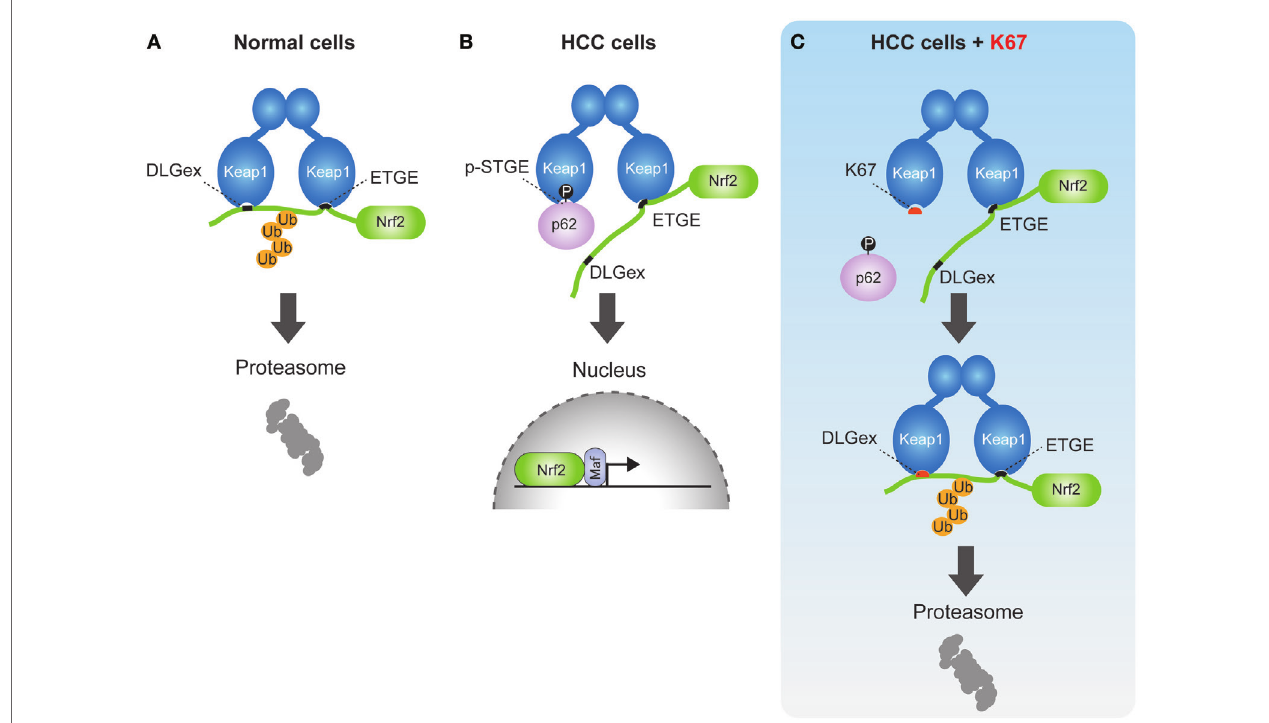
FigURe 3 | Schematic model of nuclear factor erythroid 2-related factor 2 (Nrf2) activation by phospho-p62 (A) . In normal cells, the ETGE and DLGex motifs of Nrf2 bind to the Keap1DC domain, which promotes ubiquitination of Nrf2 followed by its proteasomal degradation. (B) In human hepatocellular carcinoma cells, phospho-p62 (pS349) competitively interacts with the DLGex site on Keap1DC, resulting in the translocation of Nrf2 into nucleus. (C) K67 binds to Keap1DC at higher affinity than phosphor-p62, whereas the DLGex motif of Nrf2 binds to Keap1DC with covering K67. Nrf2 is eventually ubiquitinated and degraded by the